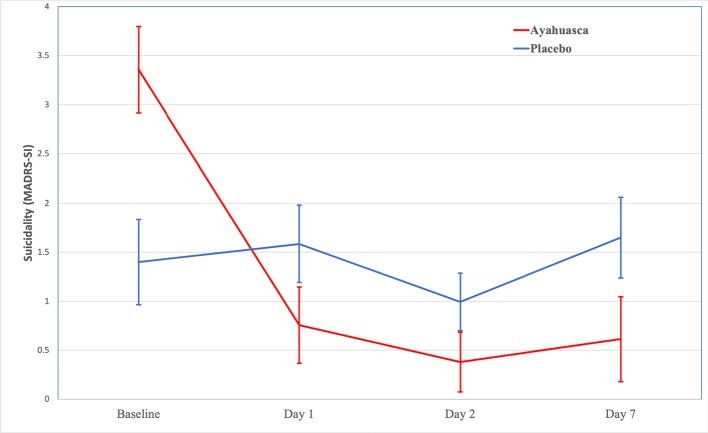
Changes in suicidality (MADRS-SI) over time. Baseline values are means (± standard error of the mean) for MADRS-SI. Day 1, Day 2, and Day 7 values are estimated marginal means (±standard error of the mean) for MADRS-SI.